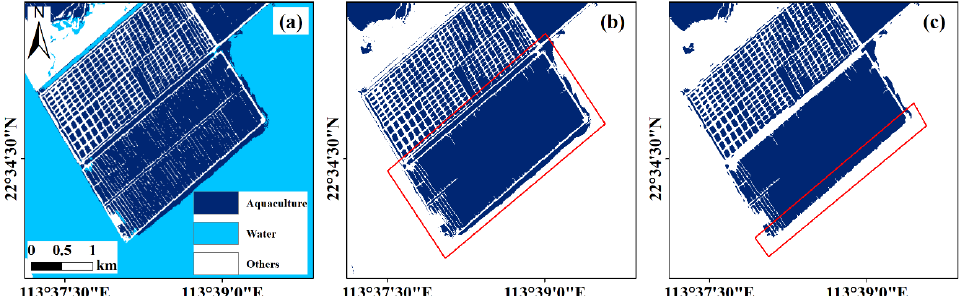
Figure 6. Overview of the morphological post processes of extracted aquaculture land in this study: ( a ) raw classification results based on RF, ( b ) exclusion of misclassified river, and ( c ) final classification map with postprocessing.